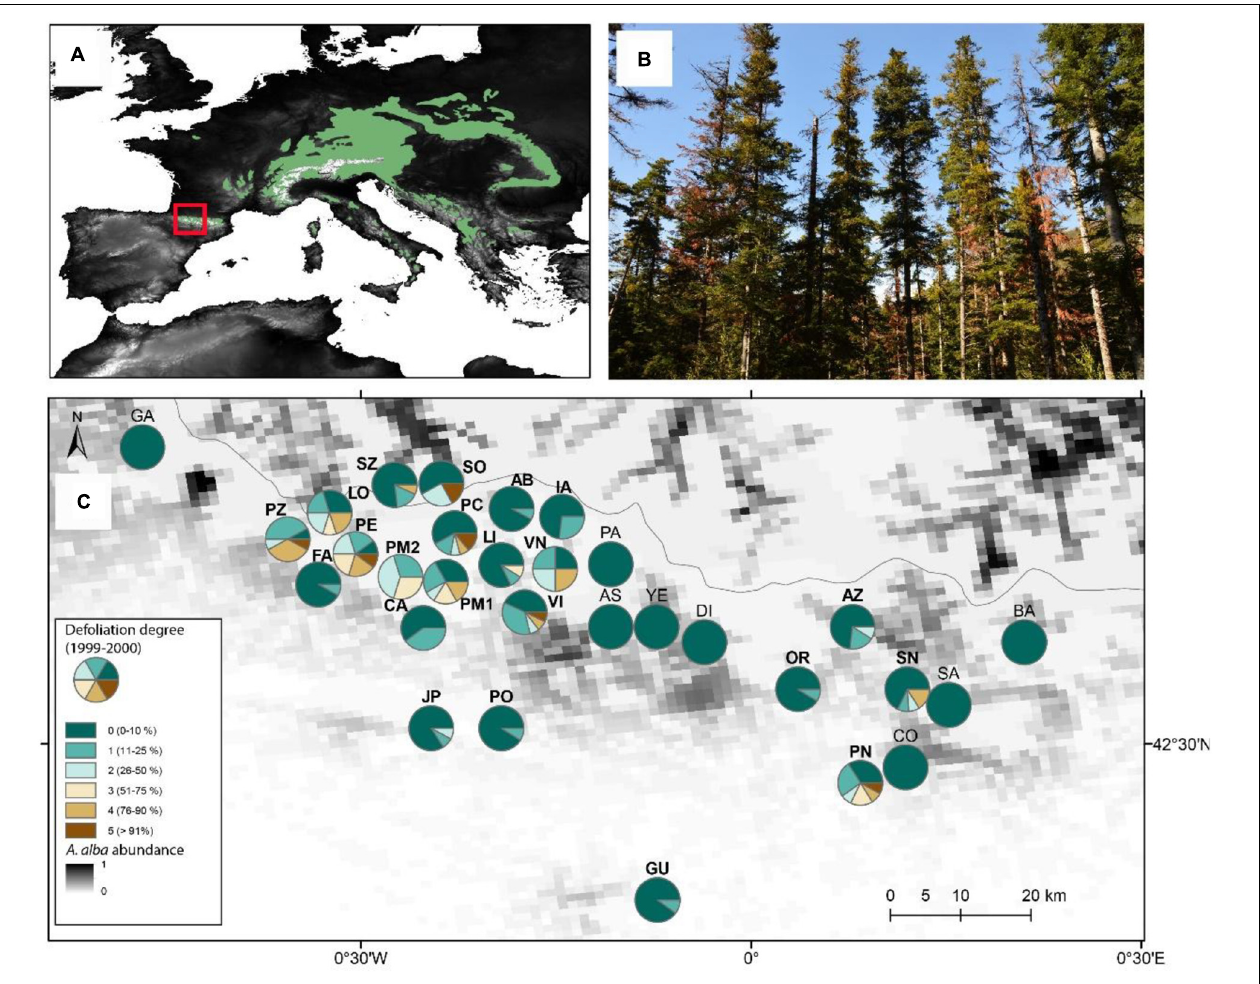
FIGURE 1 | Study sites and sampled forests in the Aragón Pyrenees (north-eastern Spain). (A) The inset shows the distribution of Silver fir in Europe and the location of the study site (red box). The gray scale represents the elevation range, increasing the values from black to white. (B) A group of Silver fir trees showing dieback or dying in the Villanúa site (VI). (C) Sampled forests in the Aragón Pyrenes. For each sampled forest, the color portions within the circles represent the proportion of trees with varying defoliation degrees (from 0 to 5, i.e., form low to complete defoliation). Sites in bold emphasizes those showing dieback in 1999-2000, whereas the line shows the boundary between Spain and France along the Pyrenees. The distribution and abundance of Silver fir (Abies alba) in Europe and the Pyrenees (box in the Europe map) is based on the data compiled by Caudullo et al.